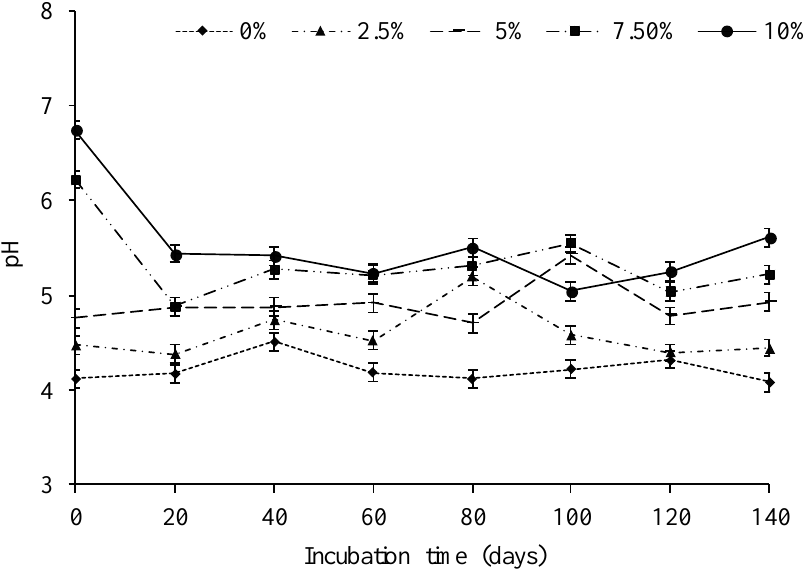
Figure 2. pH Fluctuations during incubation of a Hutton soil amended with different biochar rates. Error bars indicate standard deviation (SD).